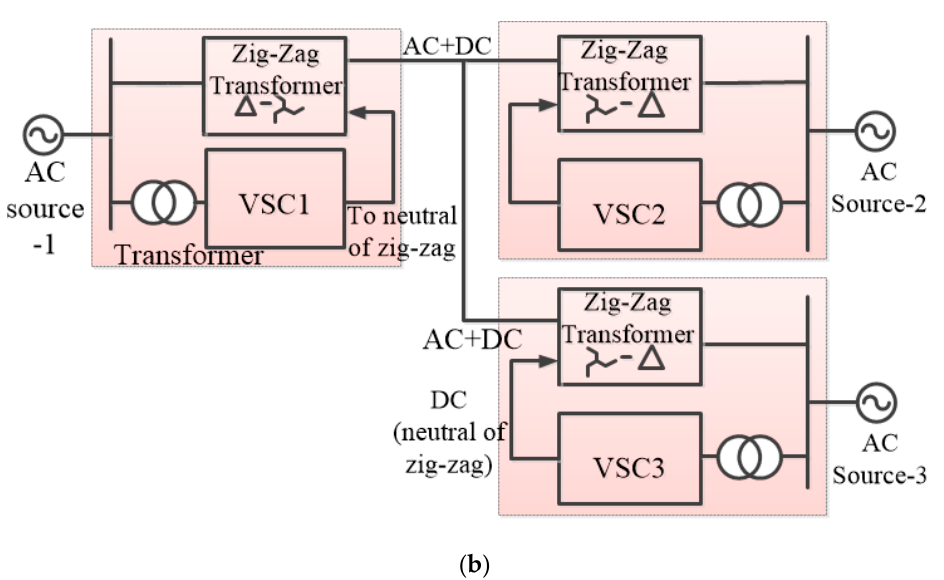
Figure 1. ( a ) Zig-zag connection of transformer; ( b ) block diagram of three-terminal, simultaneous AC–DC power transmission.